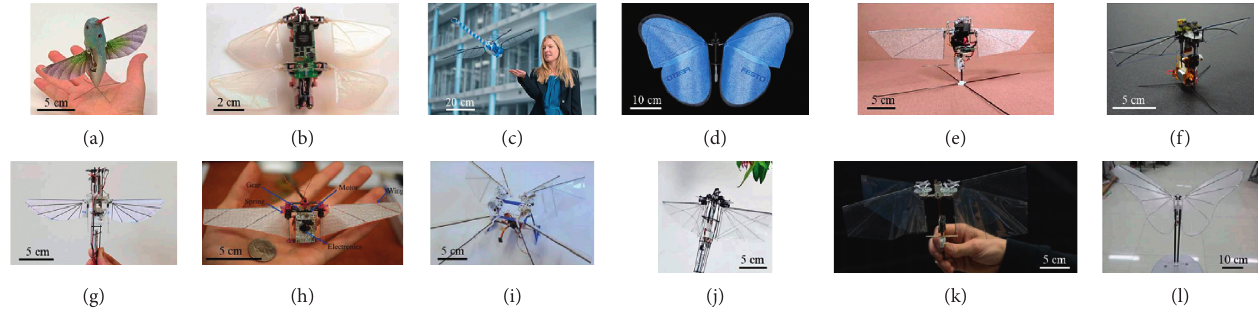
Figure 2: Motor-driven insect-inspired tailless FWMAVs capable of free controlled flying. (a) Nano Hummingbird developed by Aer- oVironment Inc. [14]. (b) TechJect Dragonfly developed by TechJect Inc. [15]. (c) BionicOpter developed by Festo AG & Co. KG [16]. (d) eMotionButterflies developed by Festo AG & Co. KG [17]. (e) Robotic Hummingbird developed by Texas A&M University [18]. (f) KUBeetle developed by Konkuk University [19]. (g) Colibri robot developed by the Universit´e Libre de Bruxelles [20]. (h) Robotic Hummingbird developed by Purdue University [21]. (i) Quad-thopter developed by Delft University of Technology [22]. (j) NUS-Robobird developed by the National University of Singapore [23]. (k) DelFly Nimble developed by the Delft University of Technology [24]. (l) Butterfly-type ornithopter developed by Beihang University [25].